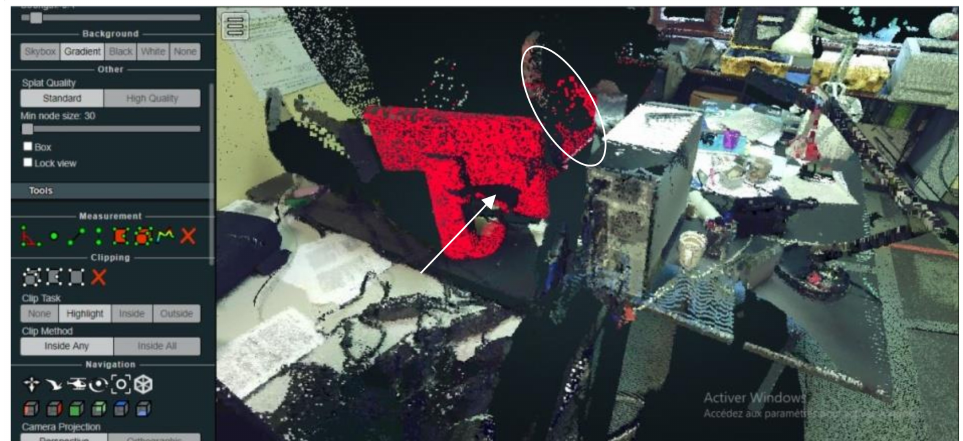
Figure 26. Influence of the scattered structure of the point